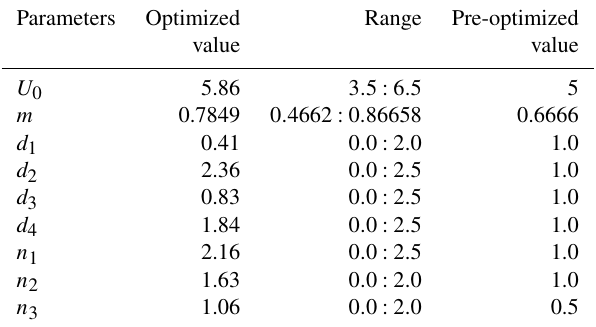
Table 3. Pre-optimized and optimized parameter sets and parameter ranges for optimization step